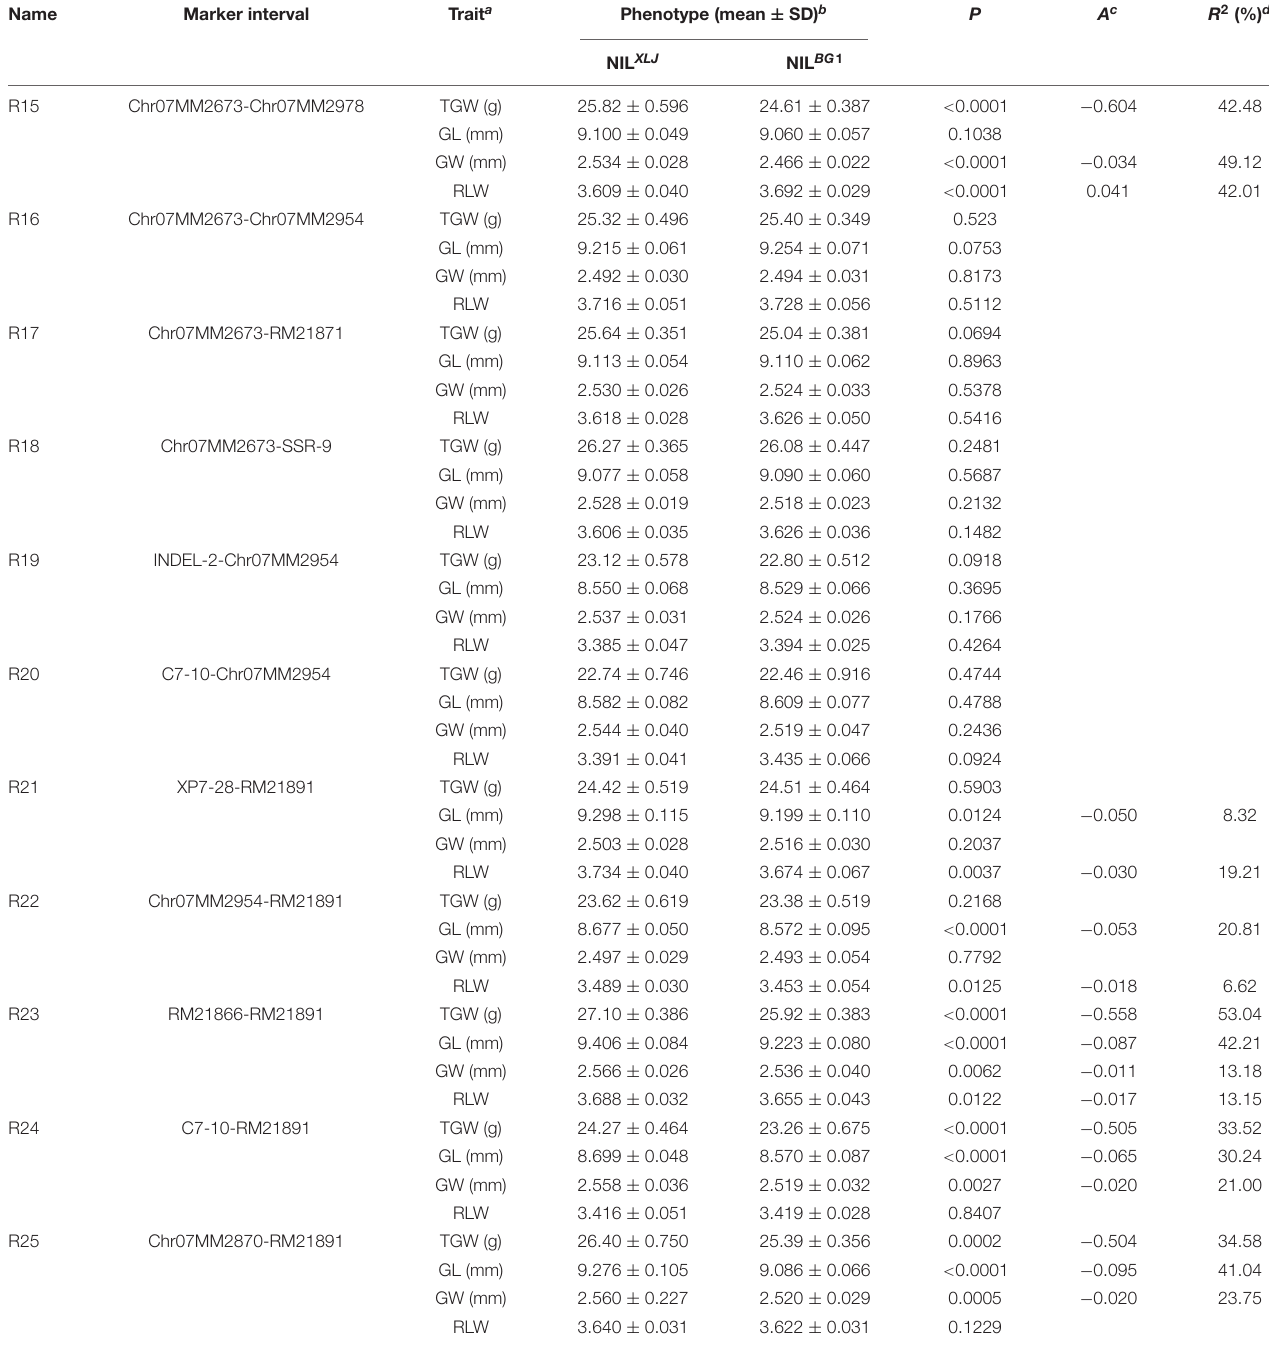
TABLE 3 | Dissection of qTGW7.2 into two QTLs using eleven residual heterozygous populations in BC 4 F 10